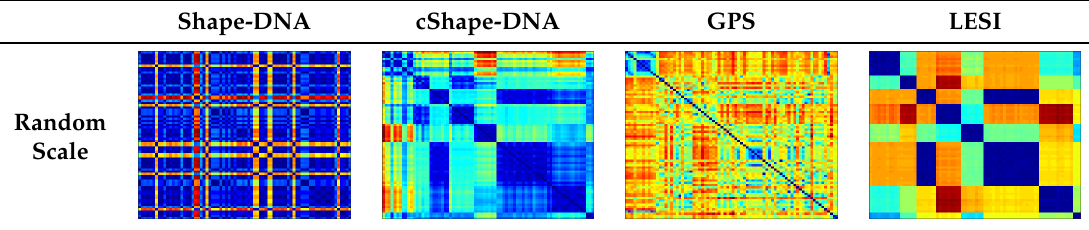
Figure 9. 2D PCA projection of shape descriptors computed by: ( a ) original Shape-DNA; ( b ) cShape-DNA; ( c ) GPS; and ( d ) LESI algorithms over scaled version of the TOSCA dataset by a randomly chosen factor of 0.5, 0.875, 1.25, 1.625, or 2.